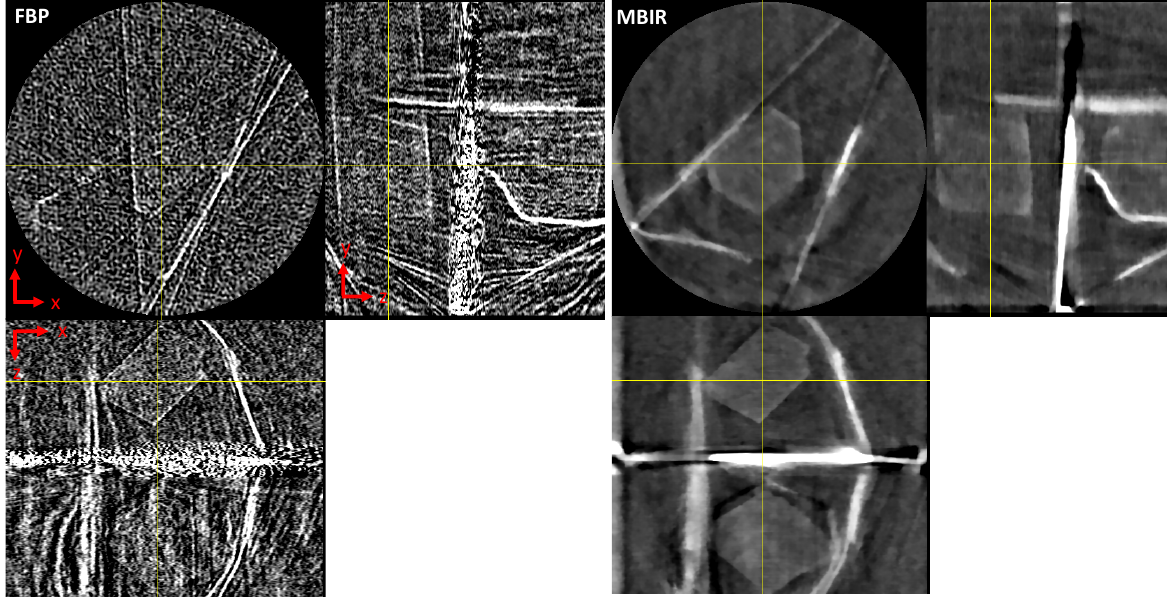
Figure 6. XY, XZ and YZ cross sections of the final reconstruction corresponding to the first wavelength bin. Notice that the features of the sample are clearly visible in MBIR even though the input data has only 30 projections. The filter and regularization parameters are chosen for approximately similar visual resolution. Notice that the MBIR approach results in a significantly lower noise reconstruction compared to the FBP